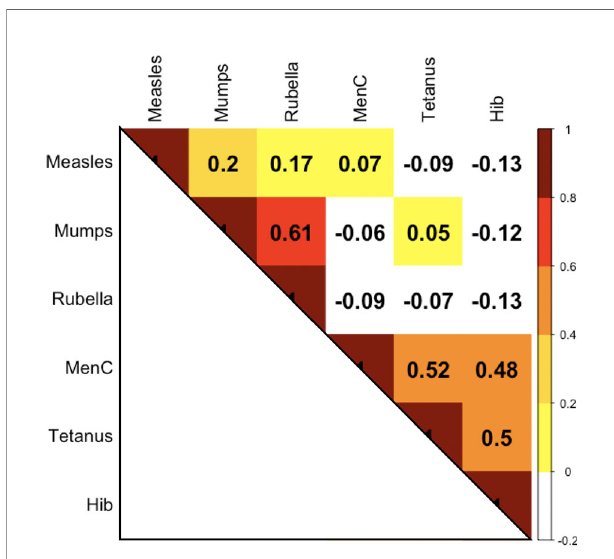
FIGURE 5 | Correlation (expressed as Spearman correlation coef fi cients) for pairwise comparisons of antibody responses to the 12-month vaccinations at 13 months of age MenC, Meningococcus C; Hib, Haemophilus in fl uenzae type